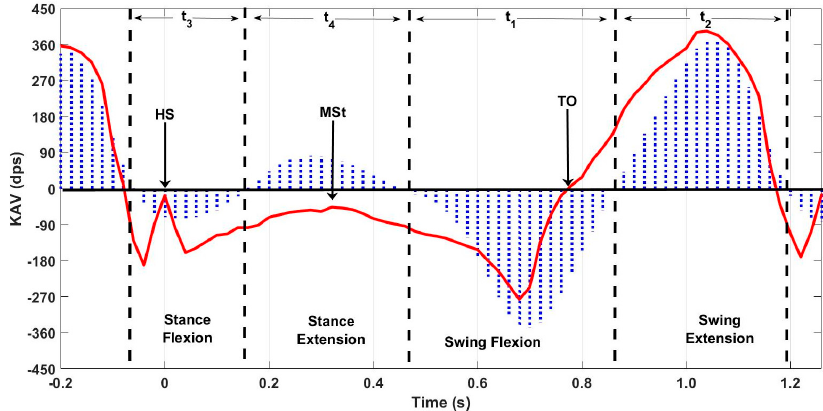
Figure 5. Swing and stance flexion time intervals. Times between zero ‐ crossings in the Vicon KAV signal are delimited by the dashed lines and correspond to the physical time intervals of stance and swing flexion and extension. Blue area, Vicon KAV signal; Red line, MAPR SAV signal used to identify HS, MSt, and TO.